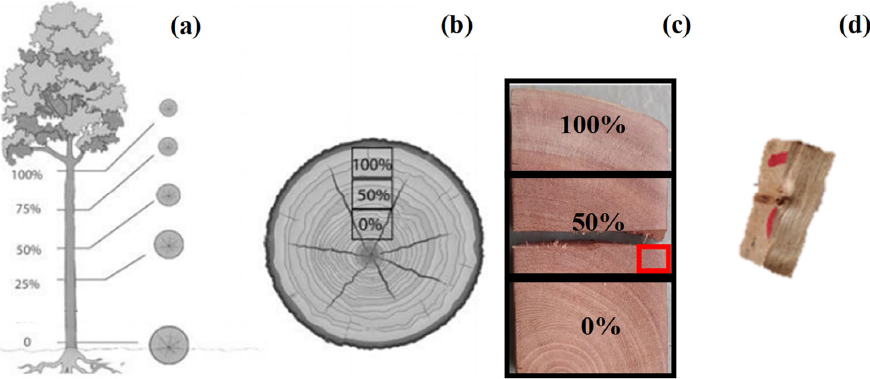
Figure 1. Representation of the sampling points of Khaya grandifoliola . ( a ) longitudinal positions of the stem, at 0, 25, 50, 75, and 100% of the total height; ( b ) radial positions of the tree transversals, in the form of disc-shaped; ( c ) specimen removal point; and ( d ) fragment used for maceration removed from the specimen. Adapted from Moraes [16].